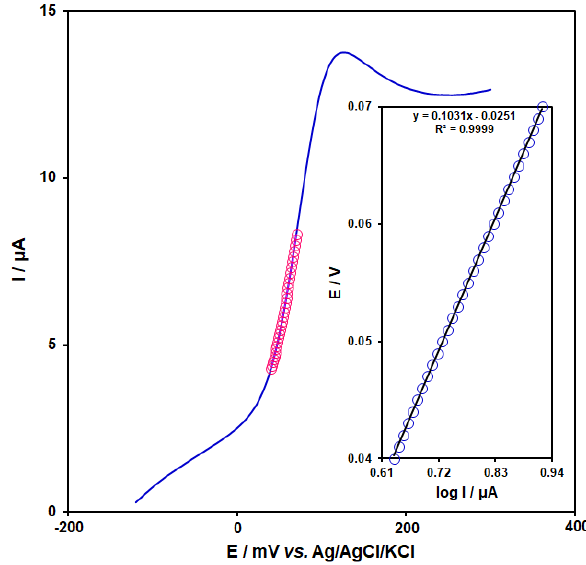
Figure 8. Linear sweep voltammogram response for CoMOF-GO/1-M,3-BB/CPE in 0.1 M PBS (pH 7.0) with a scan rate of 20 mV.s − 1 in the presence of 250.0 μM DA (Circles are the Tafel region). Inset: the Tafel plot derived from the rising part or the corresponding voltammogram.